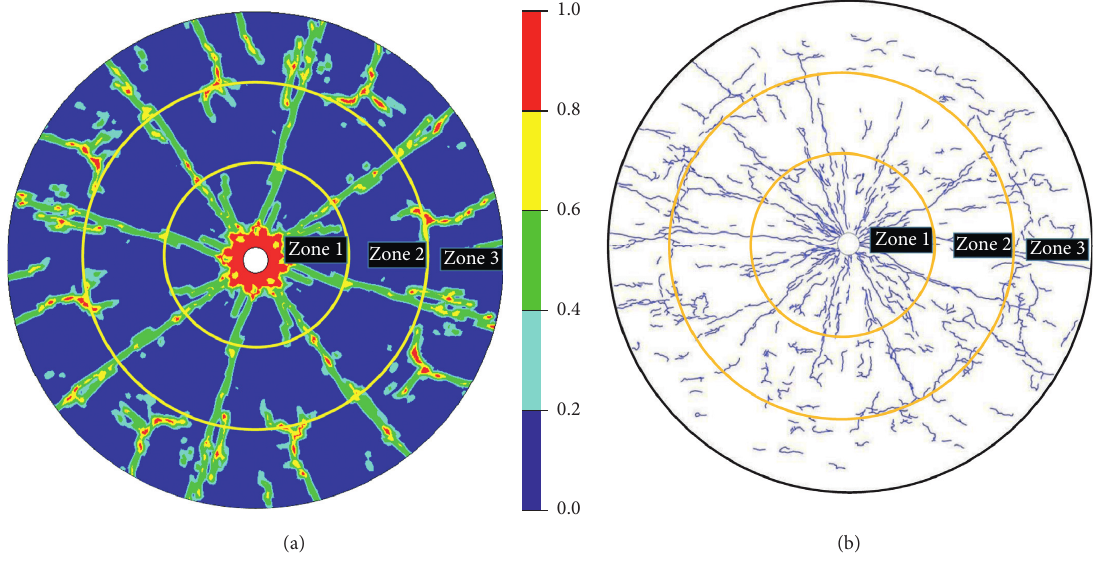
Figure 5: Comparison of (a) simulated crack pattern and (b) experimental crack pattern [58].